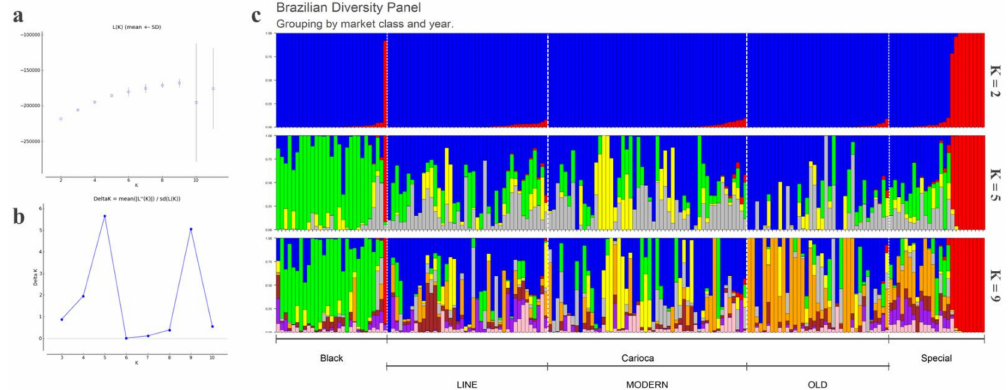
Figure 1. ( a ) Mean values of L (k) for the 20 runs of each K. ( b ) Plot of ∆ K for each K value. ( c ) Structure analysis for 185 Brazilian cultivars grouped by commercial class (i.e., Black, Carioca, Special) and year of launch for the Carioca group (i.e., Carioca lines, modern Carioca, old Carioca) for K = 2 (top clustering), K = 5 (middle clustering), and K = 9 (bottom